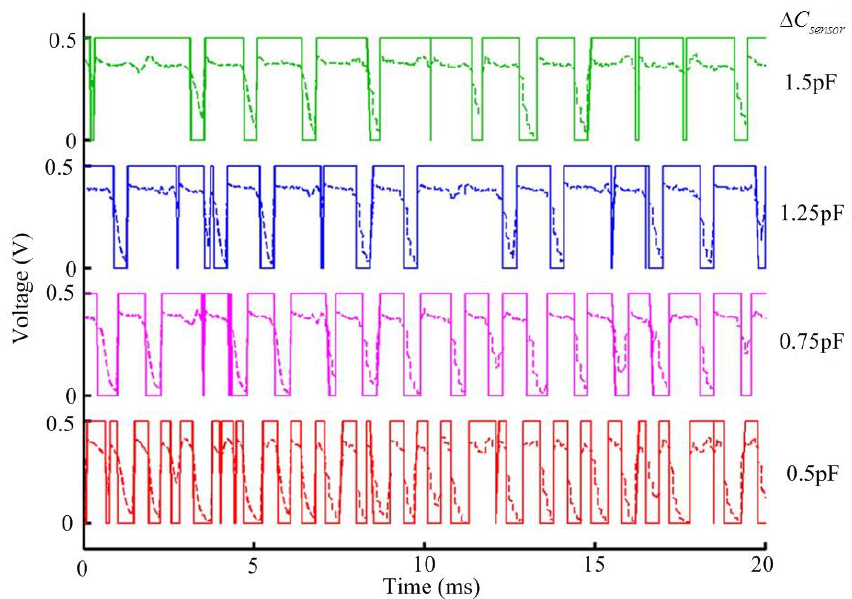
Figure 7. Measured outputs (dotted line) and digitized over-sampled outputs (solid line) for different Δ C of the sensor with 2 μm-thick polyimide layer at 25 ° C. sensor